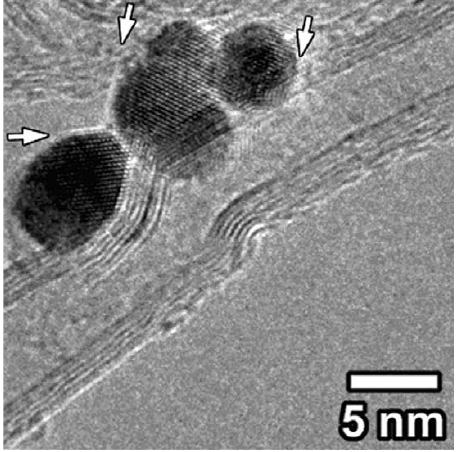
Figure 5. High-resolution TEM image of carbon nanotube supported gold with 10 wt.% gold loading prepared 60 min sonication. Small arrows indicate the different facets of gold particles. Reproduced with permission from Reference [41]. Copyright (2003)